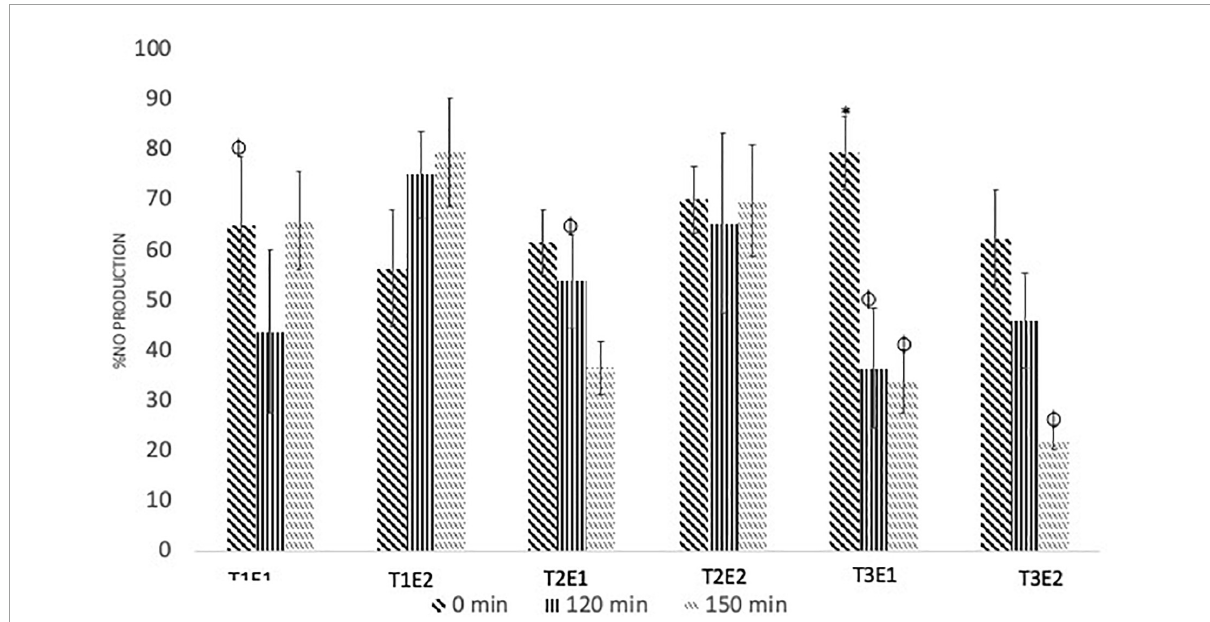
FIGURE4 Relative nitric oxide (NO) production (%) observed for CPS extracts obtained after enzymatic treatment at different combinations of temperature (T1 = 30 ◦ C, T2 = 45 ◦ C, and T3 = 60 ◦ C) enzymes (E1 = 2,500 UI/L, E2 = 250 UI/L) and time periods (0, 120 and 150 min) ( ∗ ) Highest relative production for the same combination of temperature and enzyme after Tukey statistical test, and ( φ ) lowest relative production for the same combination of temperature and enzyme after Tukey statistical test.